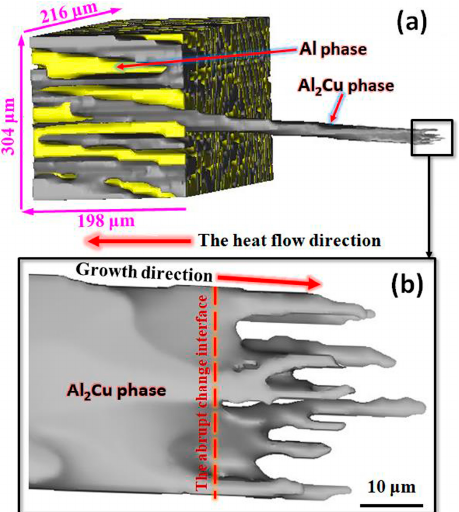
Figure 2. ( a ) The three-dimensional (3D) microstructure of the directionally solidified Al-Al2Cu eutectic in the abruptly changing, and ( b ) the corresponding local enlargement.